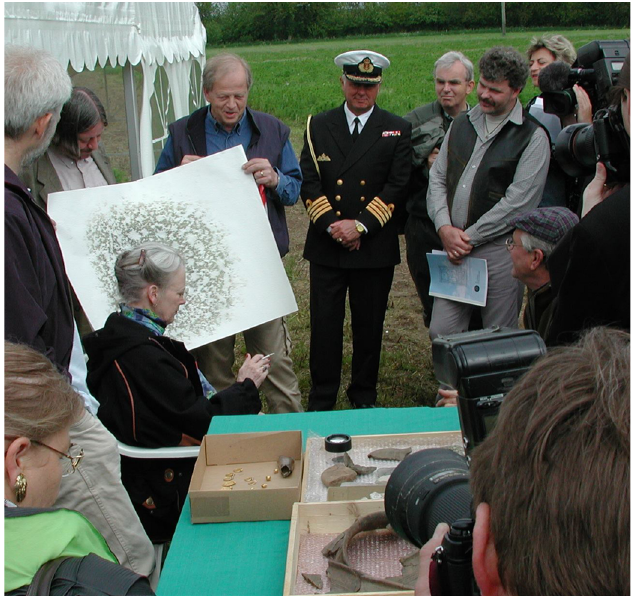
Figure 2: Bornholm 2001: The former non-professional detectorist Klaus Thorsen, an early promoter of metal-detector archa- eology in Denmark, with representatives of Bornholms Museer and the Danish National Museum present Thorsen’s recent find of a migration period hoard of Goldbracteates to the Danish Queen Margrethe II and the press. Photograph: Bornhoms